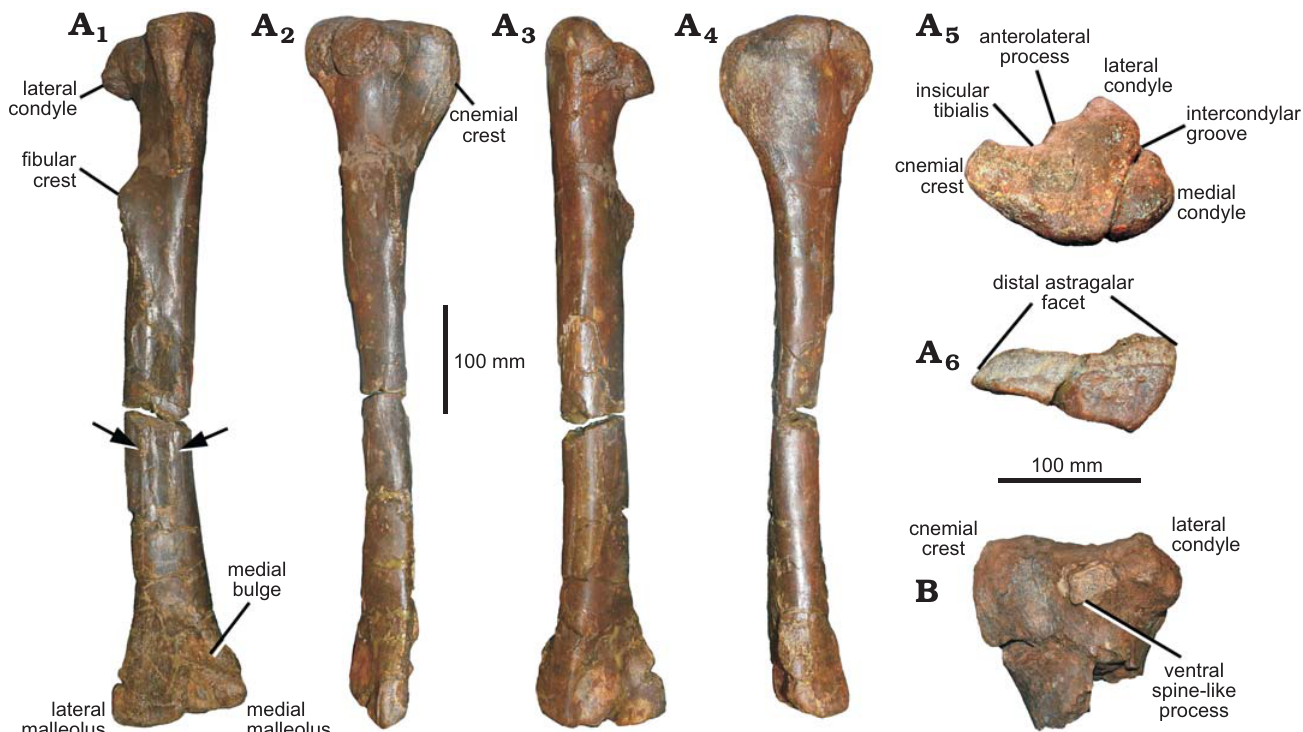
Fig. 8. Coelurosaurian theropod Phuwiangvenator yaemniyomi gen. et sp. nov. from the Early Cretaceous Sao Khua Formation of Phu Wiang, Khon Kaen Province, Thailand. A . SM-PW9B-41, right tibia in anterior (A 1 ), lateral (A 2 ), posterior (A 3 ), medial (A 4 ), proximal (A 5 ), and distal (A 6 ) views. B . SM-PW9B-40, proximal left tibia in lateral view. Arrow indicates vertical ridge on the tibia.